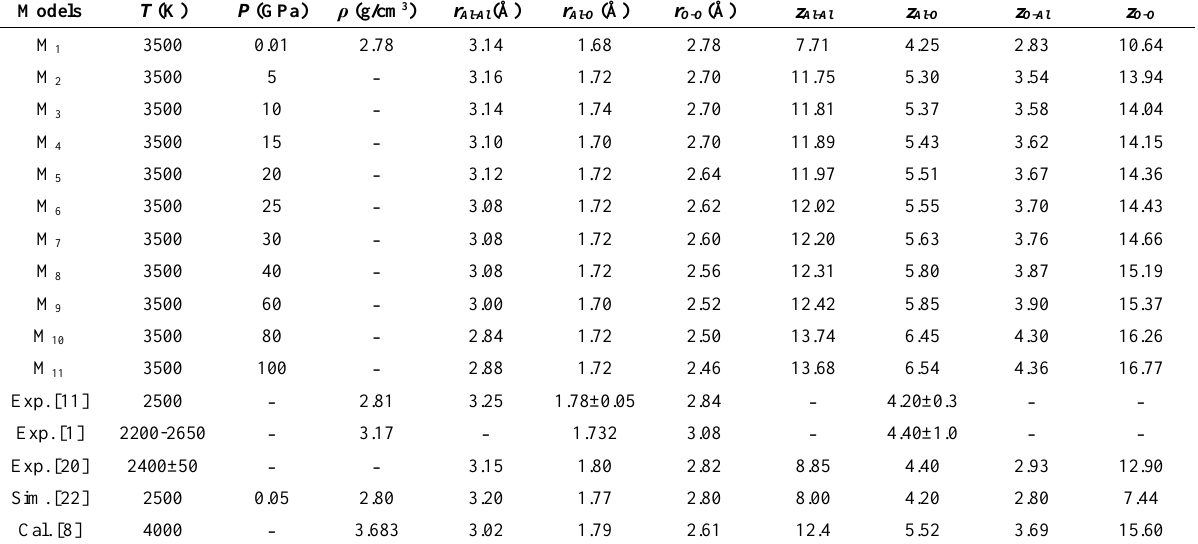
Table 1. The structural characteristics of constructed models at different pressures, experimental and simulation data. Here T , P , ρ are temperature, pressure and density, respectively; r Al-Al , r Al-O , r O-O is the inter-atomic distance for Al-Al, Al-O and O-O pair, respectively; z Al-Al , z Al-O z O-Al , z O-O are the average coordination number for Al-Al, Al-O, O-Al and O-O pair,